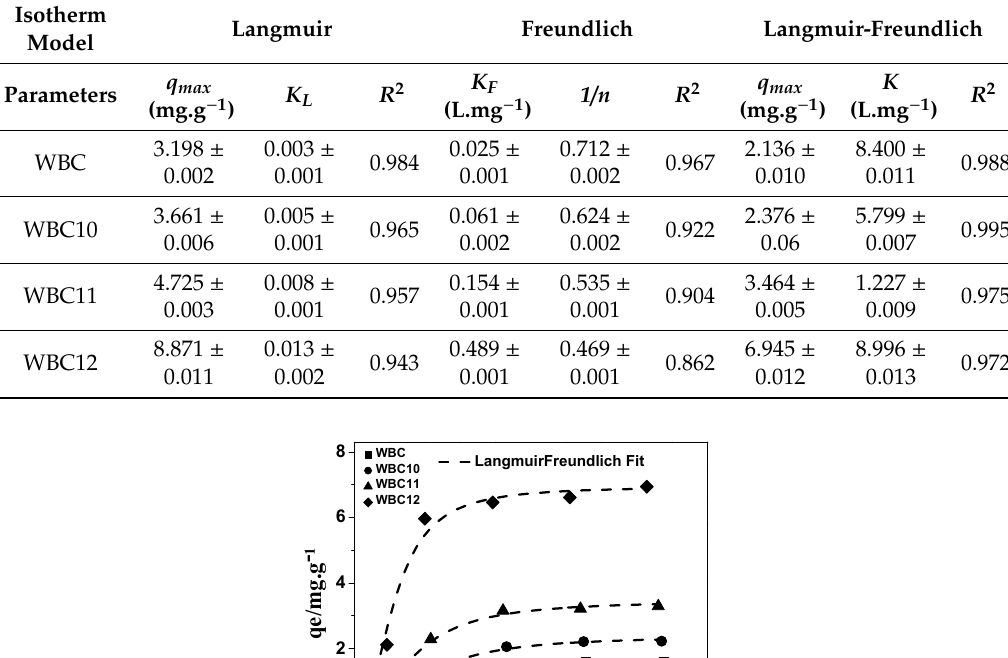
Table 3. Adsorption isotherm parameters of phosphate to WBC and WBC1x.